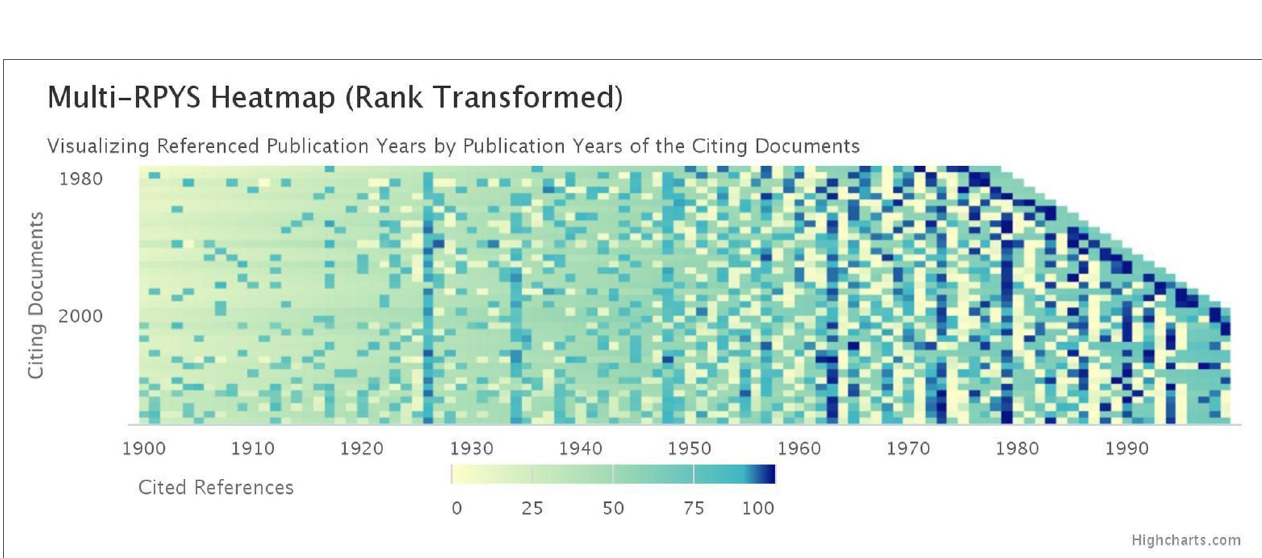
FigUre 9 | rPYs of 3,777 articles published in Scientometrics , downloaded on January 2, 2016; curve generated using the interface at http:// comins.leydesdorff.net